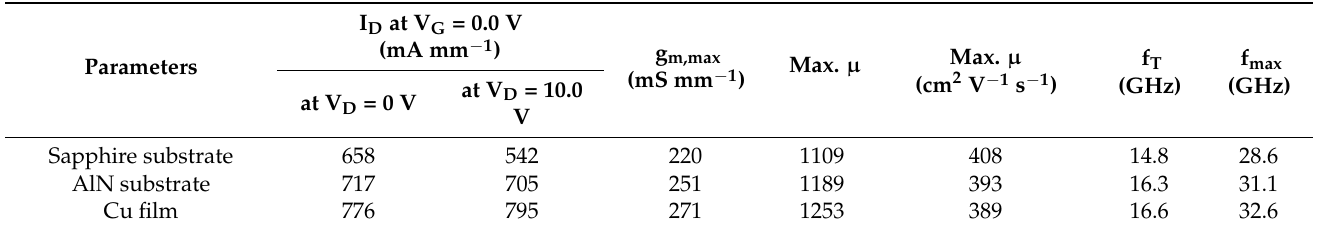
Table 5. Output GaN-based HEMT based on different properties of substrates/films. Reproduced with permission from ref. [151]. Copyright 2021